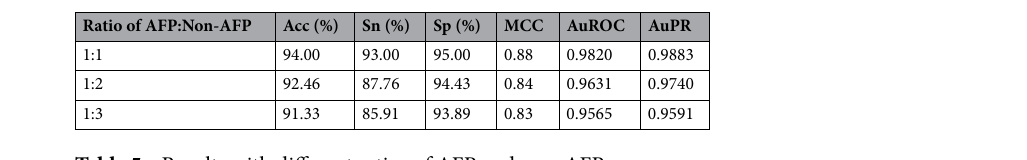
Table 5. Results with different ratios of AFP and